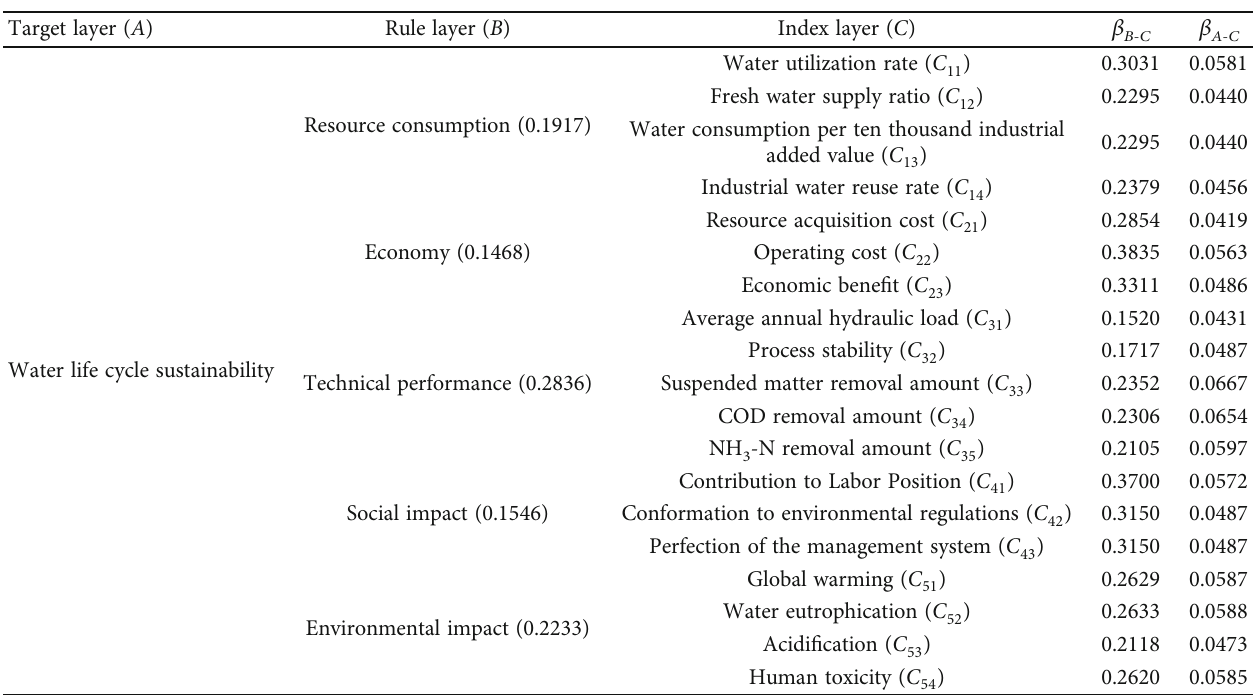
Table 17: Weight of evaluation indexes.